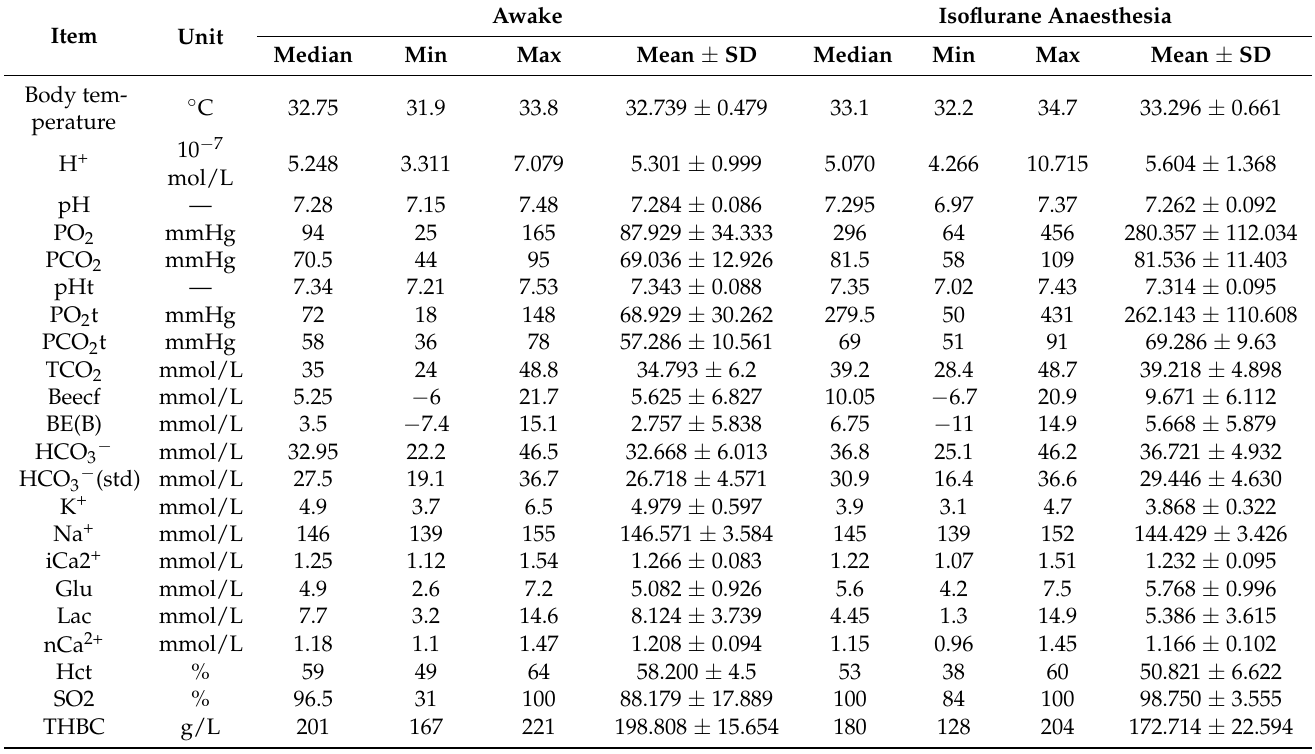
Table 3. Mean, standard deviation (SD), median, and range (Min–Max) of blood gas and lactate